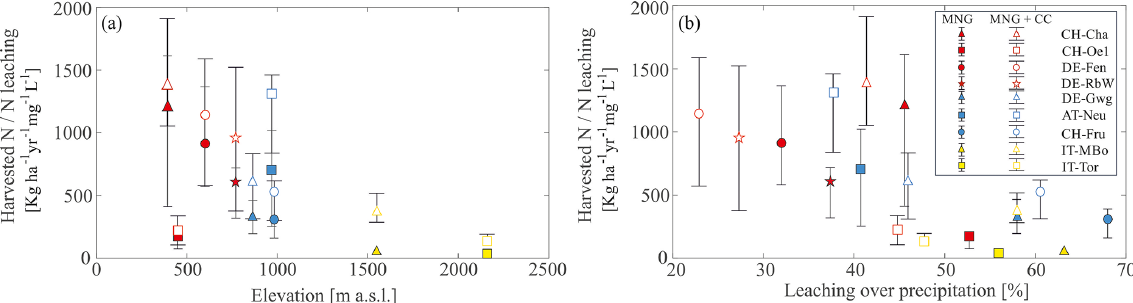
Figure 7. Ratio between harvested N and N leaching concentration as a function of site characteristics. (a) Harvested N to N leaching concentration as a function of elevation in each site. (b) Harvested N to N leaching concentration as a function of the percentage of yearly water recharge to groundwater over the yearly precipitation. In both plots the whiskers span the 25th and 75th percentiles of the interannual variability. Full markers refer to management scenarios (MNG in the legend) with the historical climate, while empty markers refer to management plus climate change (MNG + CC in the legend) scenarios.